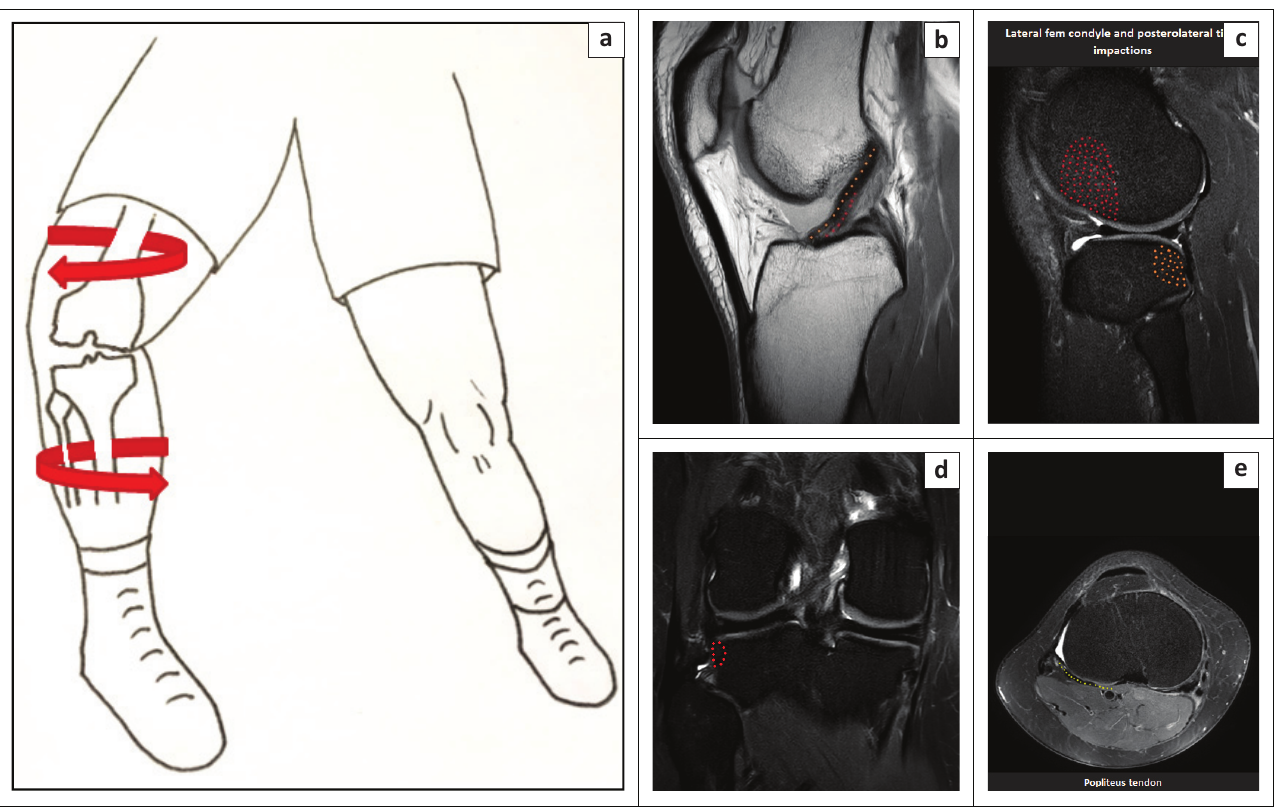
Note: Lateral and medial menisci at risk. Frequency 1 % . FIGURE 7: Flexion, varus and internal rotation: (a) Schematic depicts excessive sudden external rotation of the femur relative to tibia (effective internal tibial pivot) with knee in flexed position with varus stress on lower leg, and results in stress on the lateral supporting structures, and thus the commonly associated Segond fracture at the posterolateral tibial margin, (b) excessive rotation of the knee causes anterior cruciate ligament (ACL) disruption (stabiliser against rotation), (c) non-contiguous impactions at the lateral femoral condyle and posterolateral tibia that occur once the ACL has given way, (d) right knee site of Segond fracture (avulsion fracture at attachment of lateral collateral ligament anterior band) and (e) posterolateral corner injury (popliteus tendon ± posterolateral capsule